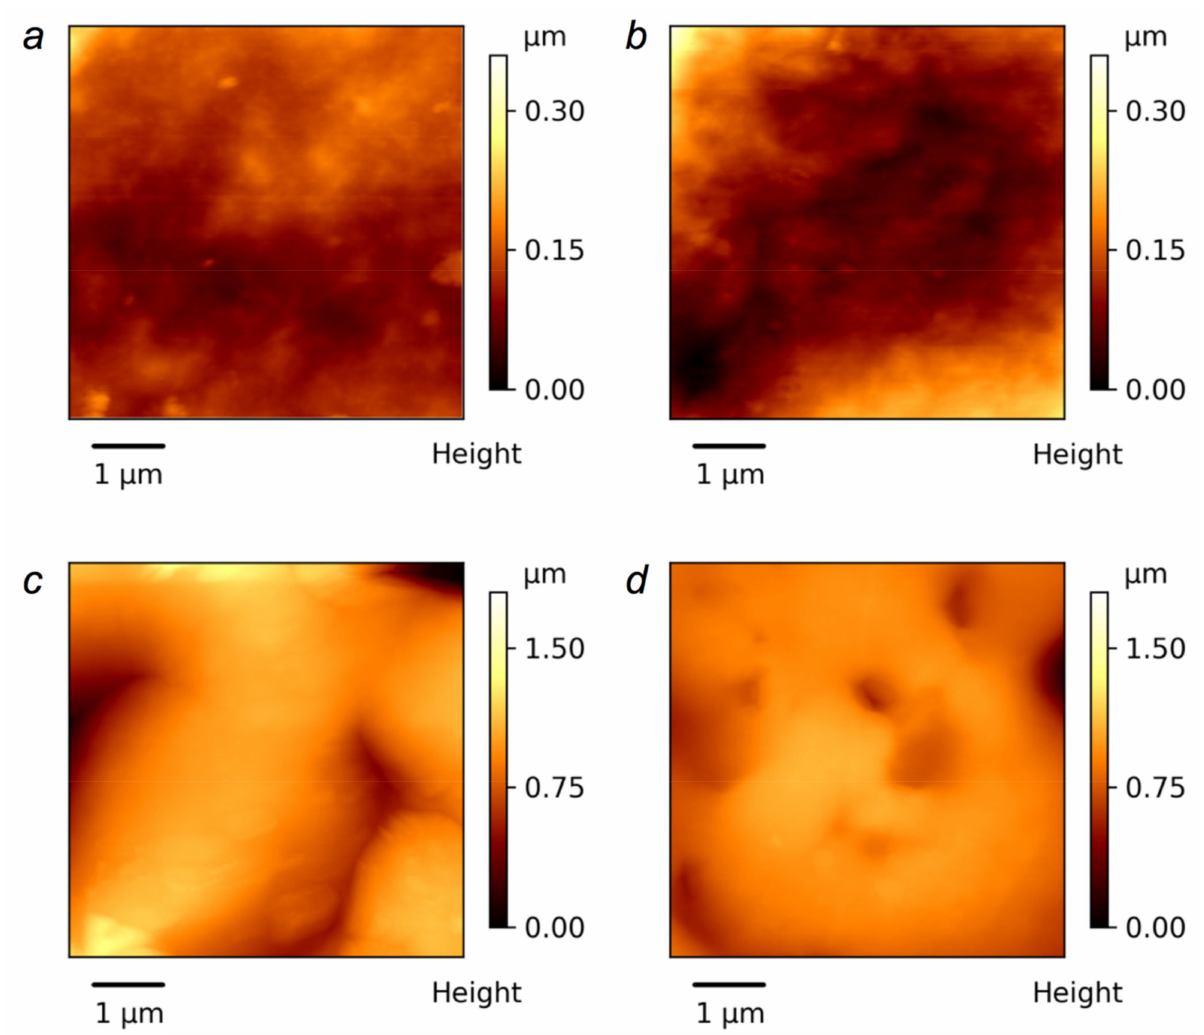
Figure 5. The AFM images of the unmodified chitosan film ( a ) and composite films with different lignin contents: 10% ( b ), 20% ( c ), and 30% ( d